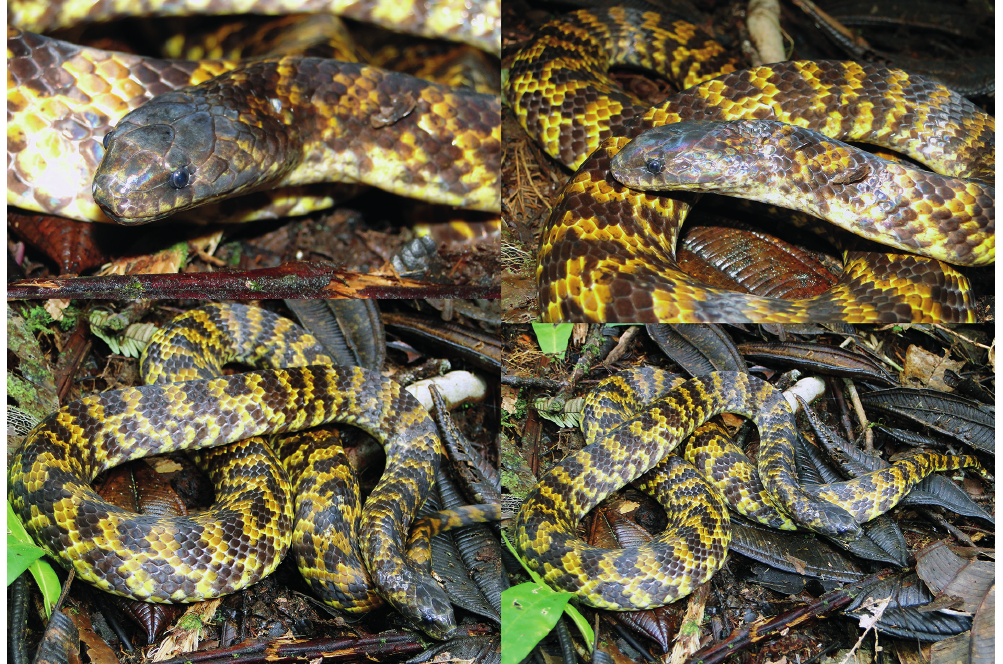
Figure 1 - General view in life of the holotype of Atractus atlas sp. nov. (mePN 14203). SVl 820 mm, Cl 106 mm + N (amputated tail).